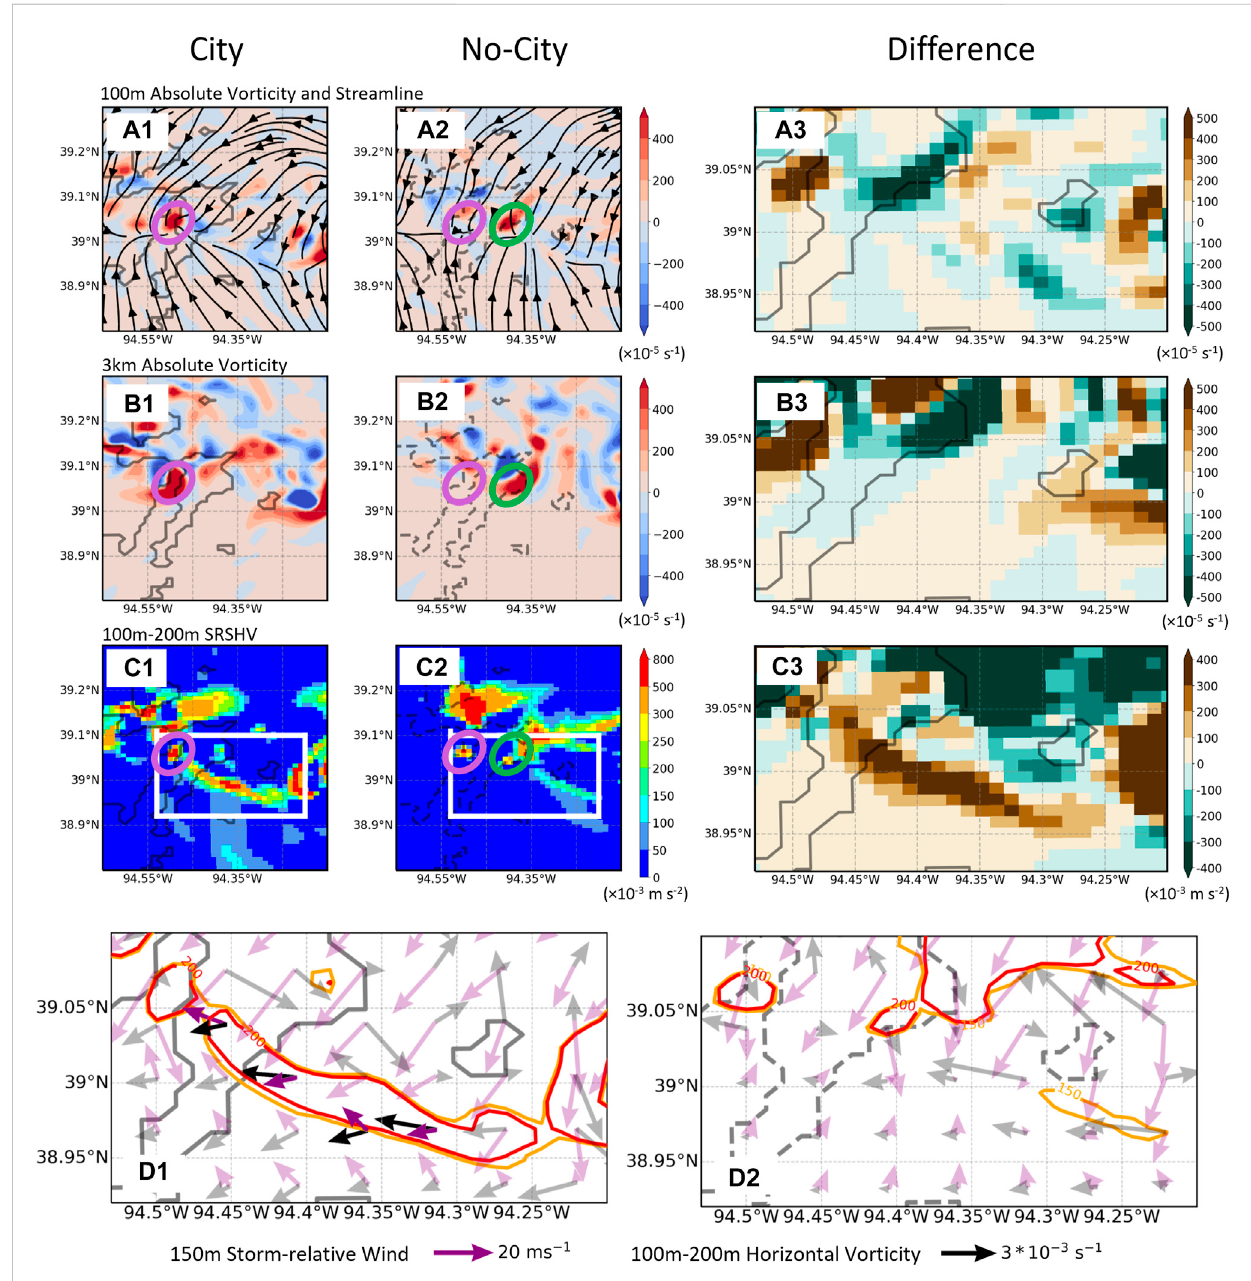
FIGURE 8 The 100 m absolute vorticity (contour) and streamline for (A1) City simulation, (A2) No-City simulation, and (A3) their difference (City — No-City) at 23:30 UTC. (B1 – B3) are same as (A1 – A3) , except for 3 km absolute vorticity. (C1 – C3) 100m – 200 m storm-relative streamwise horizontal vorticity (SRSHV). The purple and green circles on (A1,A2) , (B1,B2) , and (C1,C2) indicate the locations of near-surface mesocyclone for City and No-City simulations, respectively. The white boxes on (C1,C2) highlights the zoom-in domain used in (A3,C3) and (D1,D2) . The composite diagnostic maps are shown for (D1) City and (D2) No-City simulations, where the 150 m storm-relative wind (purple barbs) and 100 m – 200 m horizontal vorticity (black barbs) are overlaid on the SRSHV (contour). Note that barbs within the in fl ow region along the thermal boundary are highlighted in D1